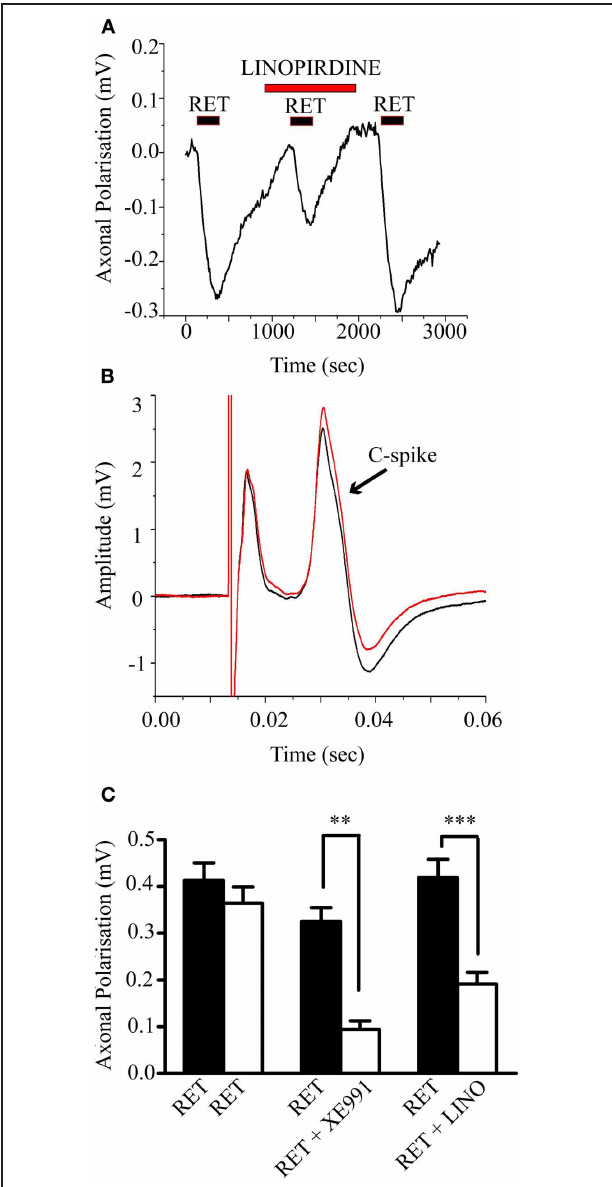
FIGURE 6 | Retigabine-induced a linopirdine-sensitive hyperpolarization of the rat vagus nerve with concomitant changes in the compound action potential generated by the unmyelinated axons (C-spike). (A) 10 μ M retigabine applied for 3min induced a prolonged hyperpolarization of the vagus nerve that was reversibly inhibited by 30 μ M linopirdine. Hyperpolarization was recorded as the change in surface demarcation potential between the central drug-perfused chamber and the distal chamber containing the cut nerve ending. (B) The C-spike compound action potential amplitude (second deflection) was increased and the spike after-hyperpolarization was decreased by retigabine (red trace). Data has been baseline subtracted for ease of comparison. (C) Mean ( ± SEM) demarcation potential changes produced by retigabine. The retigabine-induced hyperpolarization (black columns) was reproducible when reapplied after 1h (first pair, open column; n = 8) and significantly inhibited when the second application was preceded by 10 μ M XE991 (second pair, n = 7; ∗∗ P < 0 . 01) or 30 μ M linopirdine (third pair, n = 11 ∗∗∗ P < 0 .